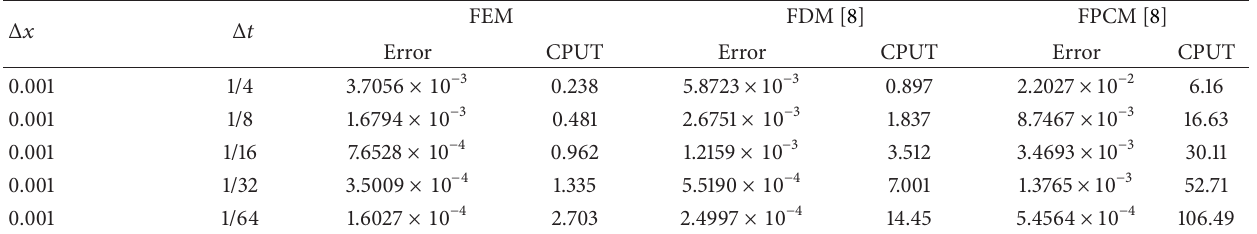
Table 5: Comparison of error and CPUT for (46) with 𝛼 = 0.9 and 𝛽 = 0.3 .